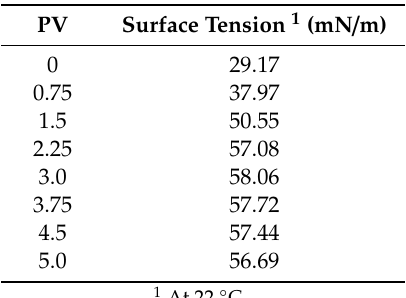
Table 8. Surface tension of outflowing solution from test 4.